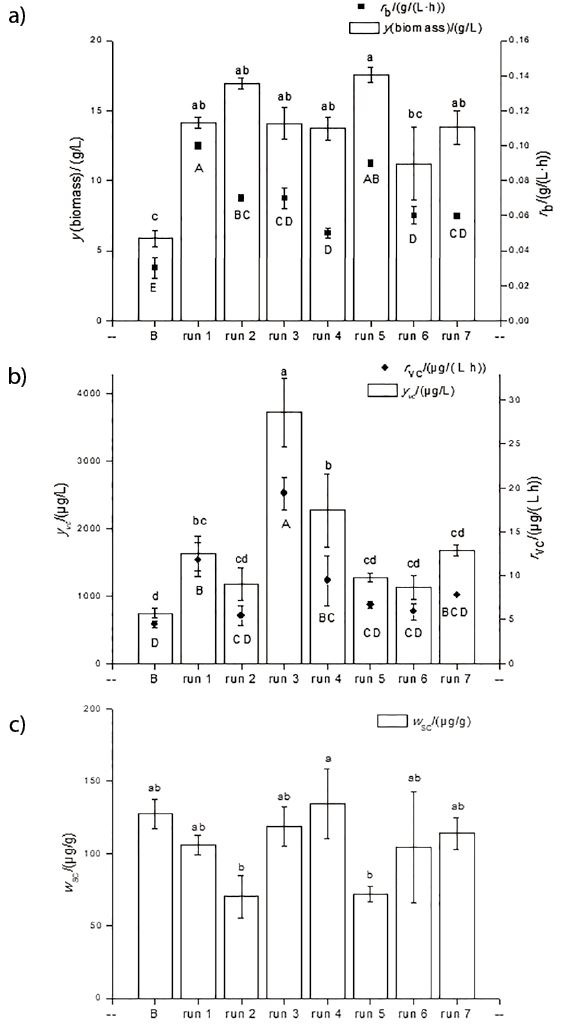
Comparison of: a) biomass concentration in batch and fed-batch fermentations with 6.5 g/L corn steep liquor and 30 g/L sugar cane molasses medium, b) volumetric concentration of carotenoids and c) specific carotenoid mass fraction. B=batch process, fed–batch run (t/h): 1) 48, 2) 72, 3) 96, 4) 48 and 96, 5) 72 and 120, 6) 96 and 144, 7) 96 and 168. The results are expressed as mean values±standard deviations (N=3); different letters (lowercase for biomass and volumetric carotenoid concentrations and uppercase for biomass and volumetric carotenoid productivity) indicate a significant difference (p<0.05) according to Tukey’s test